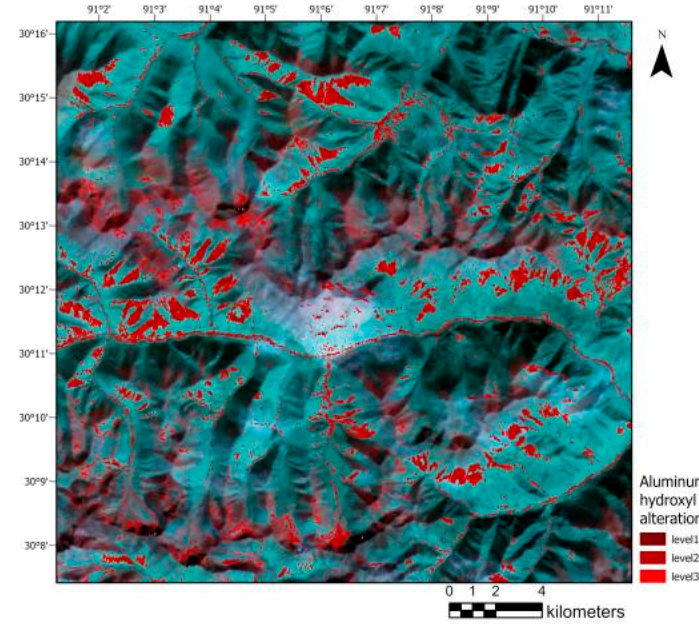
Figure 8. Aluminum hydroxyl alteration information in the enhanced band.